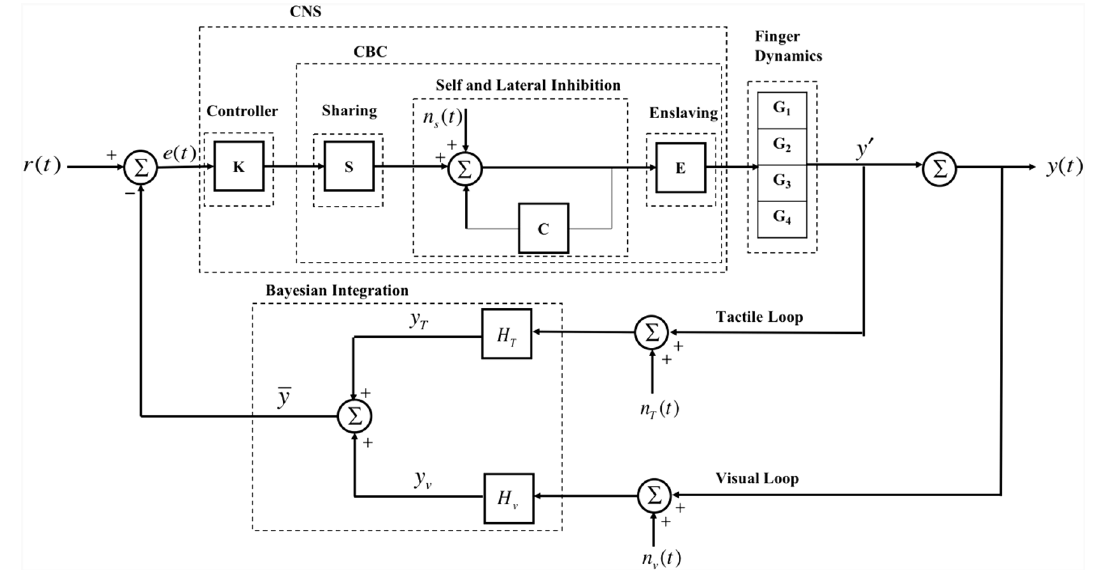
Figure 2. Schematic of the proposed model for finger force production task. The system has the desired force, r ( t ), as input and, three noises or disturbances: n s ( t ) for sharing noise, n T ( t ) and n v ( t ) for tactile loop and visual loop noises, respectively, and an output, y ( t ), i.e., sum of four finger forces. The controller, K, is a PD-lag controller that produces a command that minimizes the difference between r ( t ) and y ( t ). Sharing (S) defines the share of force that each finger needs to contribute to satisfy the total command by the controller. Self and lateral inhibition accounts for neural connection between the fingers and forms the finger synergistic interaction using a unity forward-path gain and a negative feedback-loop gain with transport delay (C). Enslaving (E) accounts for the mechanical interconnection between fingers. K, S, self and lateral inhibition and E represent the CNS in our model. Each finger dynamics ( G i , i ∈ { 1, 2, 3, 4 } ) is modeled as a second-order linear system. Sum of forces produced at each finger yields the total force. Tactile loop and visual loop simulate the tactile (from the four finger force sensors) and visual (from eyes observing the total force on screen) sensors, respectively, which are integrated using Bayesian rule and fed back to